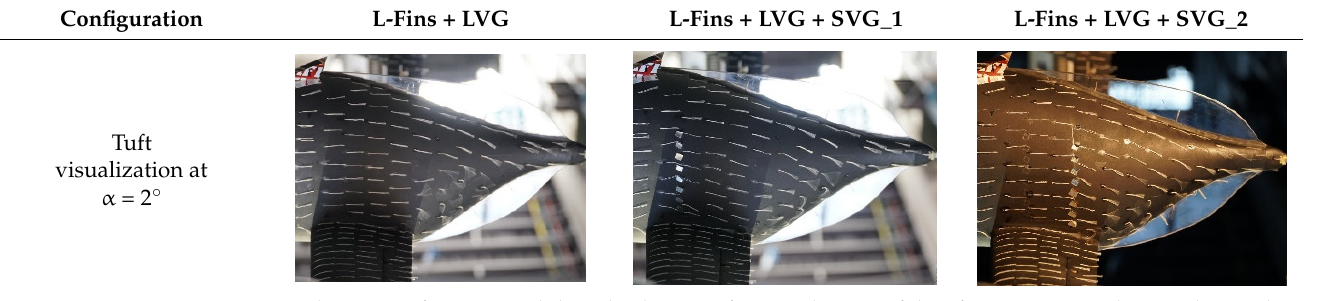
Table 4. Tuft visualization of the aft fuselage with small VG installed in configurations 1 and 2.